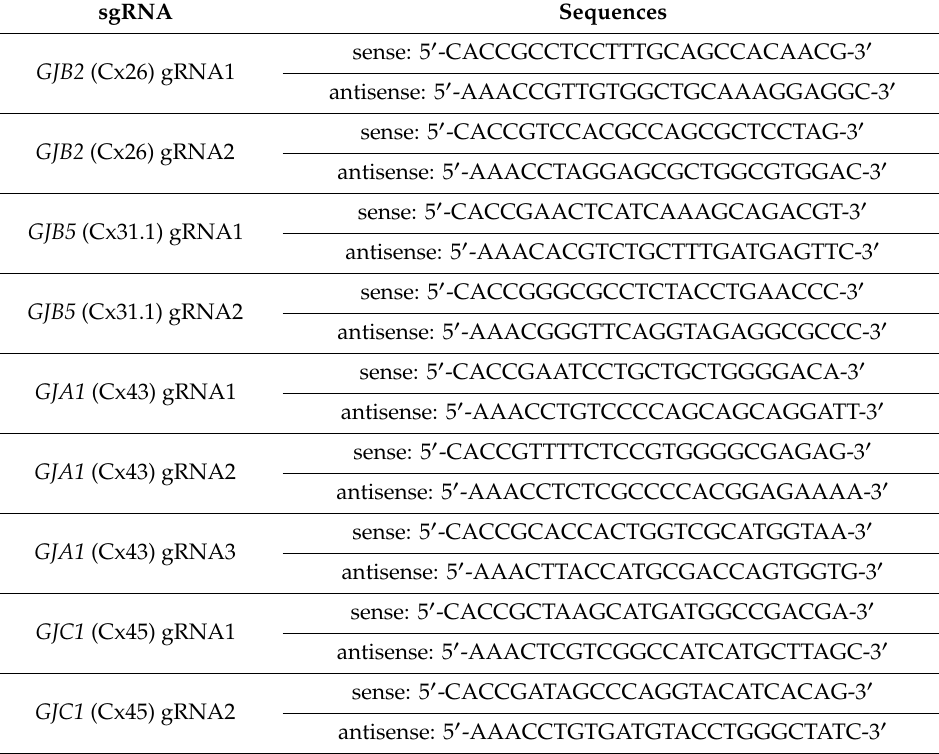
Table 1. Oligonucleotides for LentiCRISPRv2 constructs. sgRNA